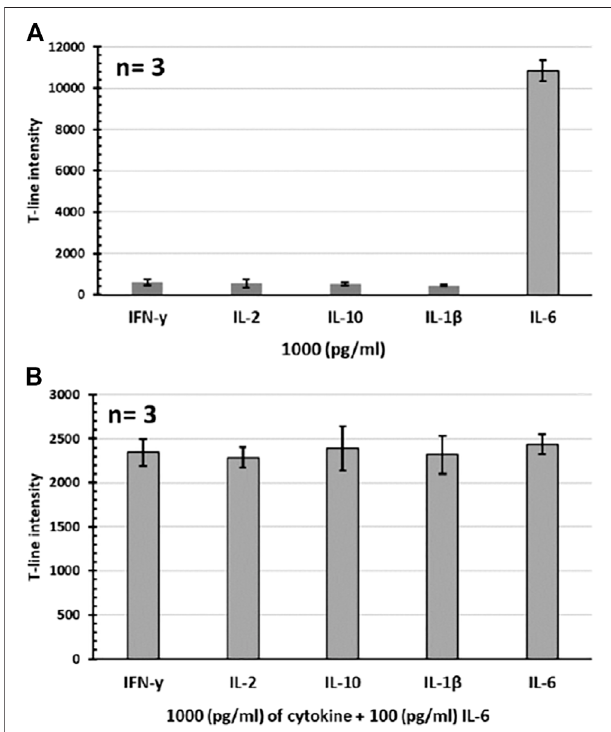
FIGURE 4 | Speci fi city tests for the developed IL-6 assay. (A) Individual cytokine samples. (B) IL-6 samples containing excess amount of individual cytokines. All tests were performed in 100% serum sample ( n (cid:1) 3).